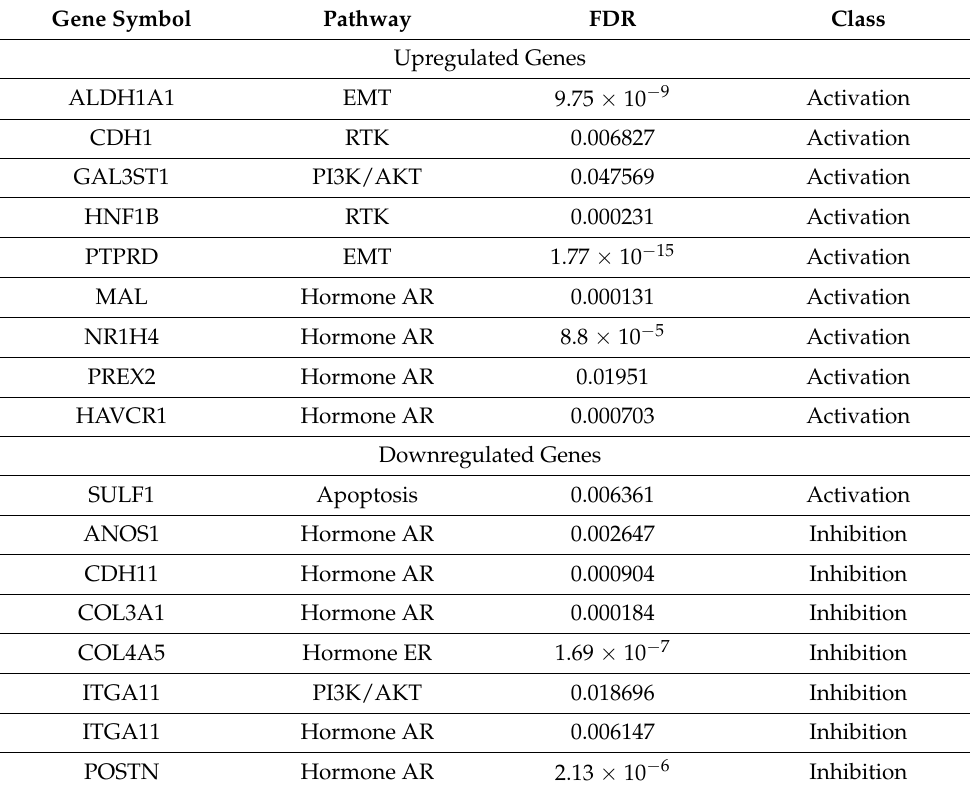
Table 1. Effect of mRNA expression on pathway activity based on TCGA-BLCA datasets.